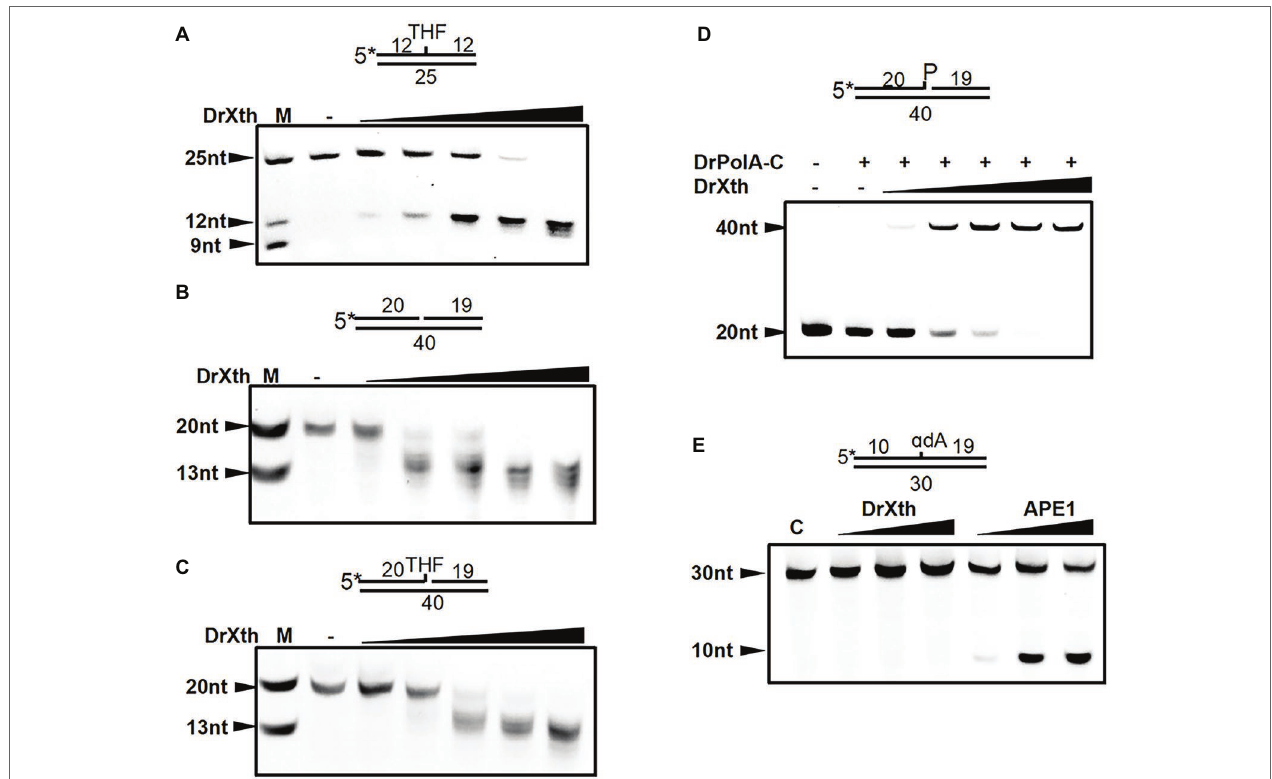
FIGURE 1 | AP endonuclease from Deinococcus radiodurans (DrXth) possesses various enzyme activities with specific DNA substrates. (A) AP endonuclease activity. DNA substrates (50 nM) were incubated with DrXth (2, 5, 8, 10, and 20 nM) at 37 ° C for 5 min. (B) 3 ′ –5 ′ -exonuclease activity. (C) 3 ′ -phosphodiesterase activity. DNA substrates (50 nM) were incubated with DrXth (20, 50, 80, 100, and 200 nM) at 37 ° C for 5 min (B,C) . (D) 3 ′ -phosphatase activity. DrPolA-C (100 nM) was added to the reaction mixture containing DNA substrates (50 nM) and DrXth (20, 50, 80, 100, and 200 nM) at 37 ° C for 10 min. (E) Nucleotide incision repair (NIR) activity. DNA substrates (50 nM) was incubated with DrXth and APE1 (5, 10, and 20 nM) at 37 ° C for 10 min.